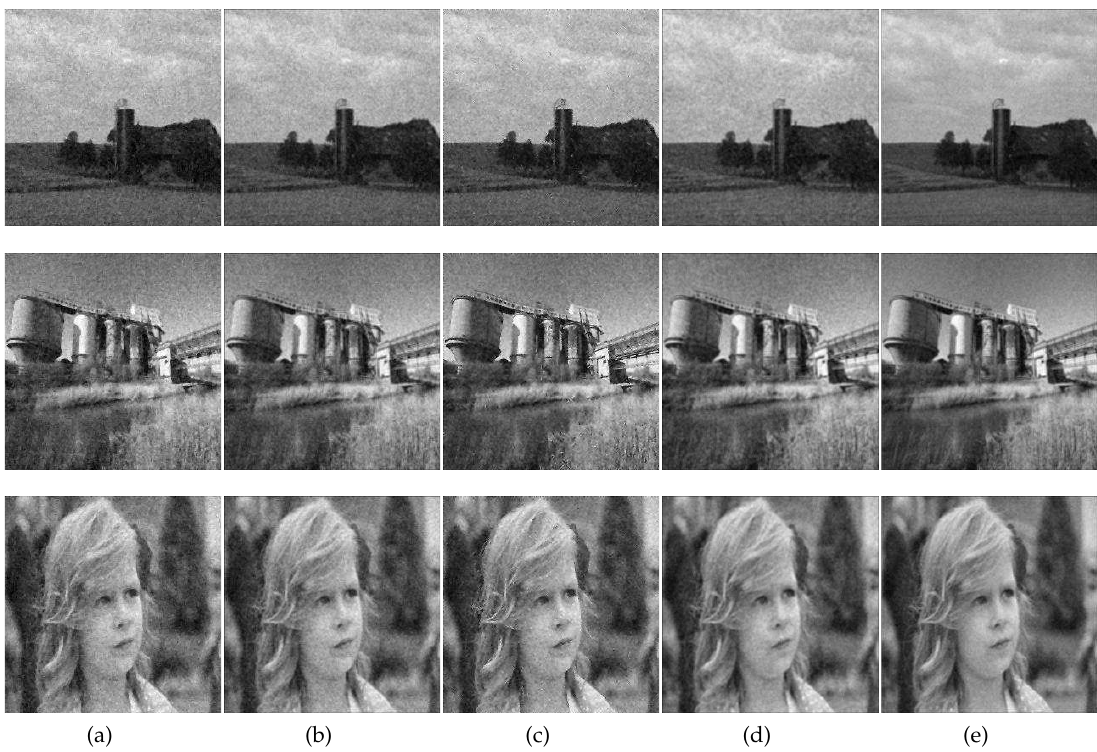
Figure 2. The comparison results of the restored images based on four algorithms (with 300 iterations). ( a ) by the ML-EM algorithm; ( b ) by the CPF-adaptive algorithm; ( c ) by the RT-IEM algorithm; ( d ) by the VBBD-TV algorithm; ( e ) by our algorithm with β = 1.31 and ξ =